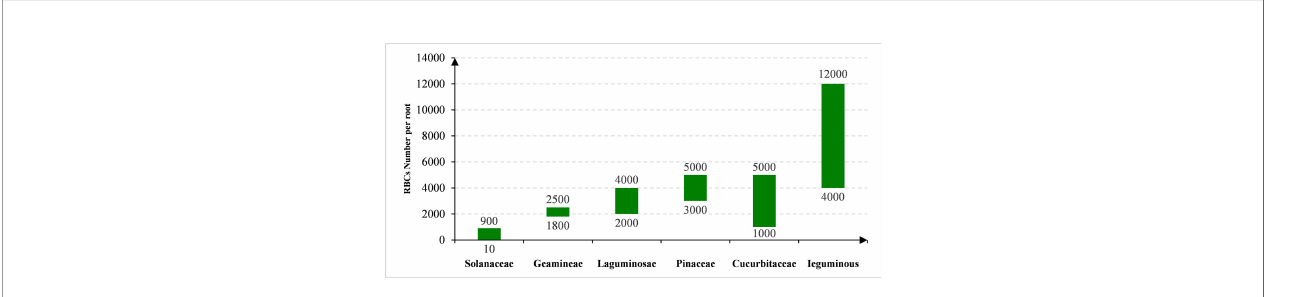
FIGURE 1 | The species-dependent production of